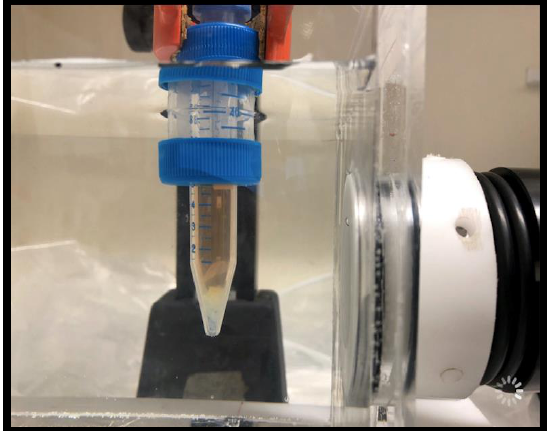
Figure 8. Electromagnetic shockwave applicator attached to the right side of a water bath treating a biofilm specimen inside the falcon tube. The substrate fibrin clot is visible at the bottom tip of the container, which is RPMI filled, removing air interfaces near the treatment zone.